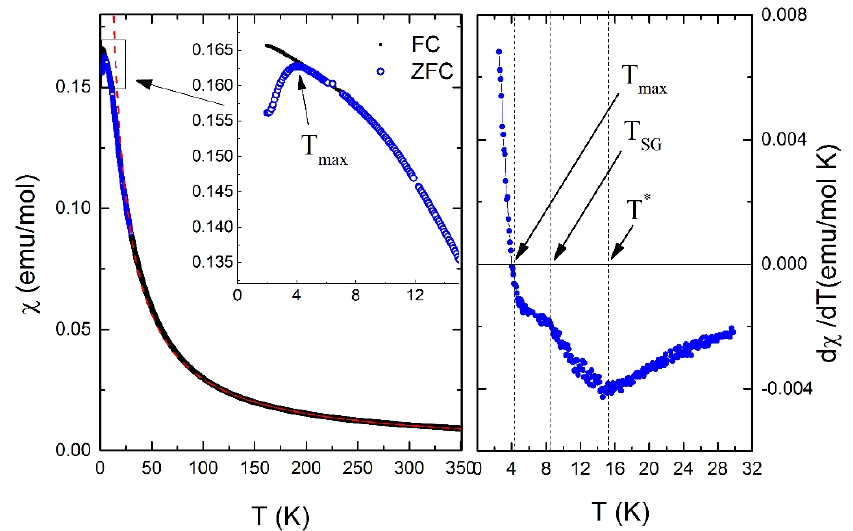
Figure 2. ( Left ) Static susceptibility of Li 2.4 Ni 1.8 Sb 1.2 O 6 as a function of the temperature: field cooled (solid black circles) and zero field cooled (open blue circles) at external field of 0.7 T. Curie-Weiss fit is shown by red dashed curve. ( Right ) derivative of the low temperature part of zero field cooling static susceptibility.